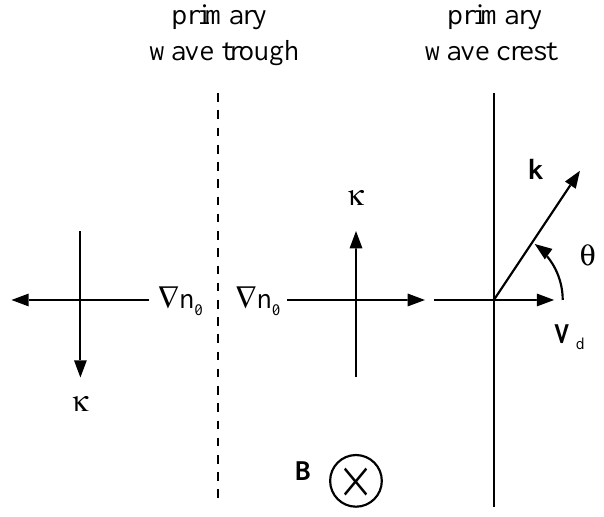
Fig. 7. Diagram illustrating the spectral width model developed in Sect.